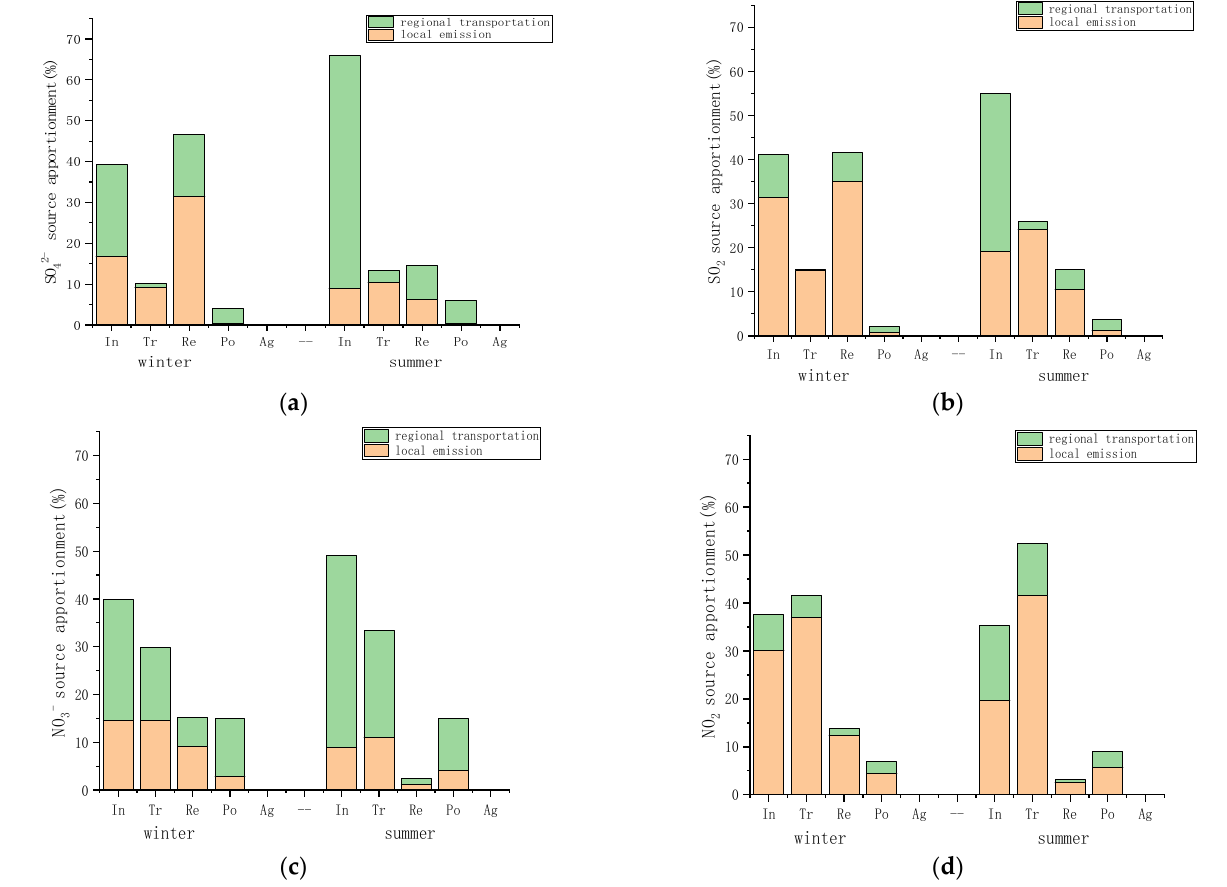
Figure 7. Source apportionment results for SNA and its precursor gases. ( a ) the SO4 2− source apportionment results, ( b ) the SO 2 source apportionment results, ( c ) the NO 3− source apportionment results, ( d ) the NO 2 source apportionment results.